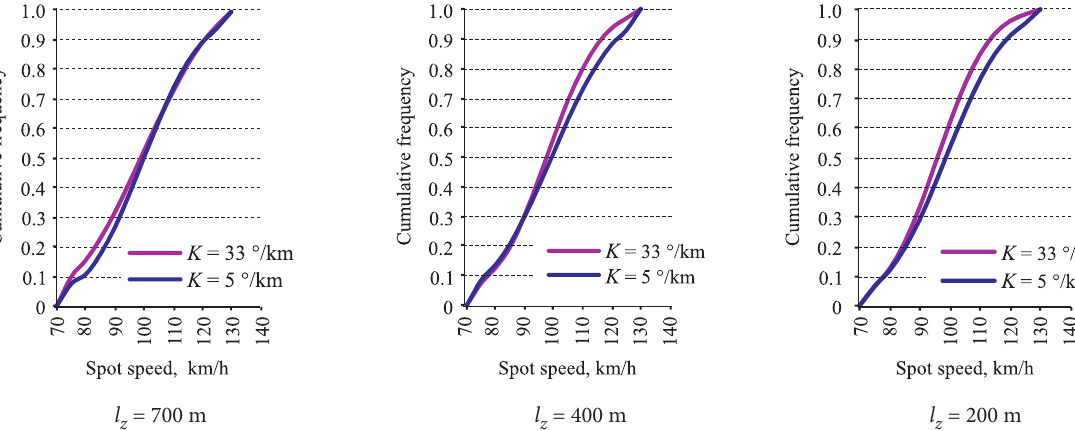
Fig. 3. Speed distribution functions for the road sections with the non-rutted pavement, various available sight distances and the bendiness of 5 �/km and 33 �/km